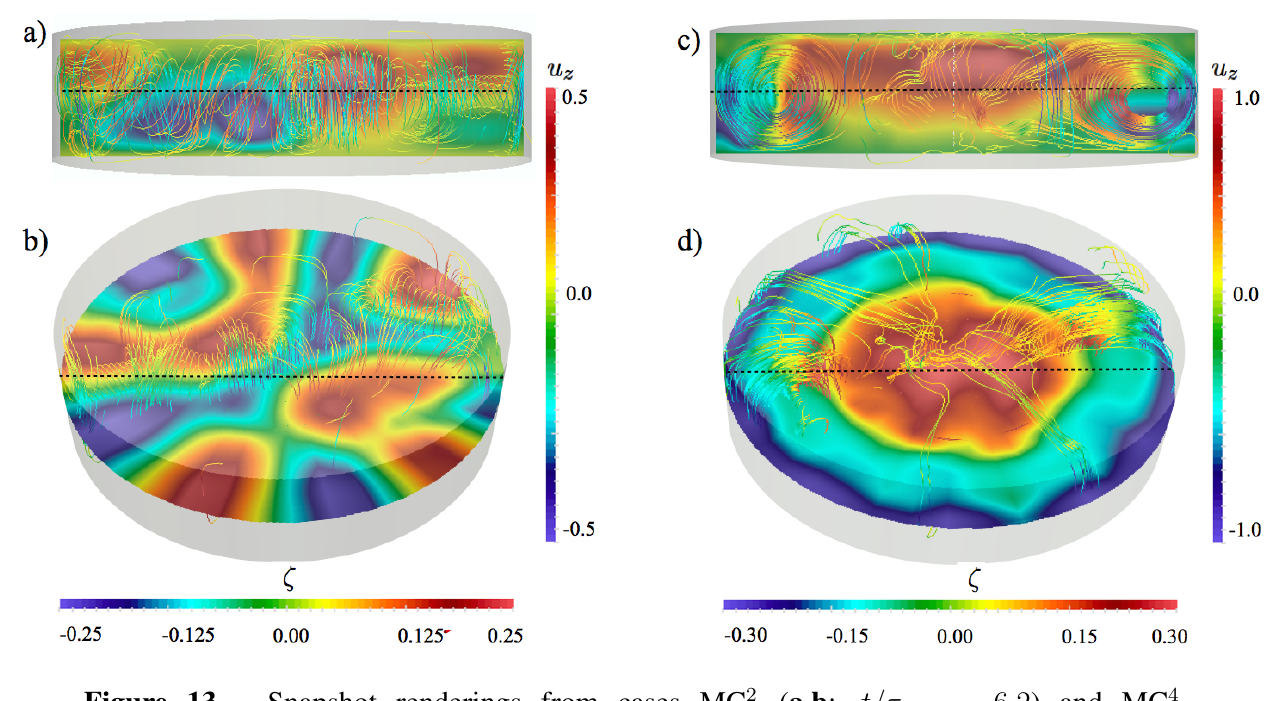
Figure 13. Snapshot renderings from cases MC 2 = 2 . 0 ). Panels are defined identically to Figure 7, but the color scales ( c , d ; t/τ κ